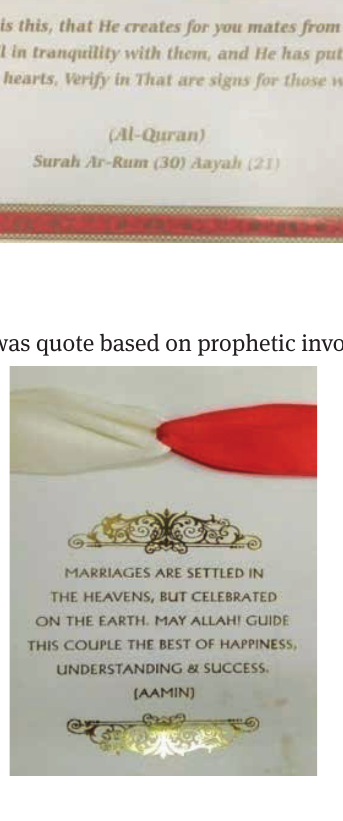
Figure 2: Opening with a